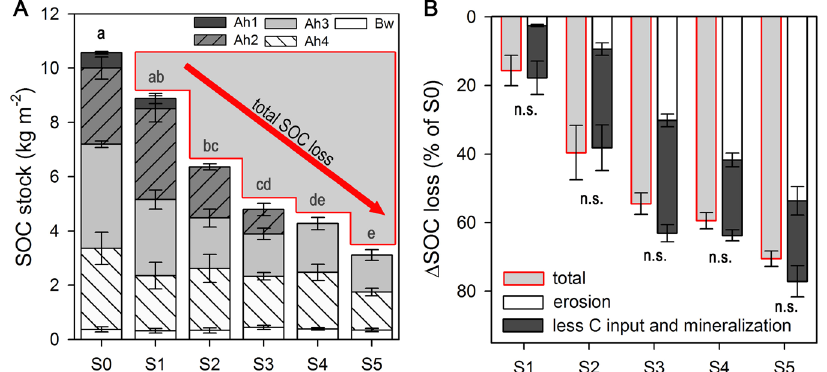
Fig. 4 Soil organic carbon (SOC) stocks and losses with increasing degradation. Total SOC stocks along the degradation sequence (S0 – S5) down to 30 cm for each horizon ( A ). SOC losses by erosion and by reduced C input and increased SOC mineralization ( B ) during degradation (S1 – S5). Lowercase letters indicate signi fi cant differences in SOC stocks between degradation stages. The absence of signi fi cant differences (n.s.) between quanti fi ed total SOC losses (red outline) and the calculated sum of erosion- and mineralization-induced SOC losses con fi rms the validity of the estimations. Error bars display standard error.